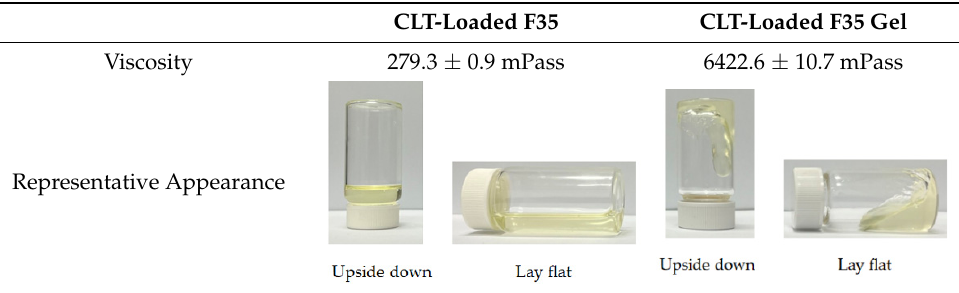
Table 4. Viscosity and representative appearance of CLT-loaded F35 and CLT-loaded F35 gel at ambient temperature.